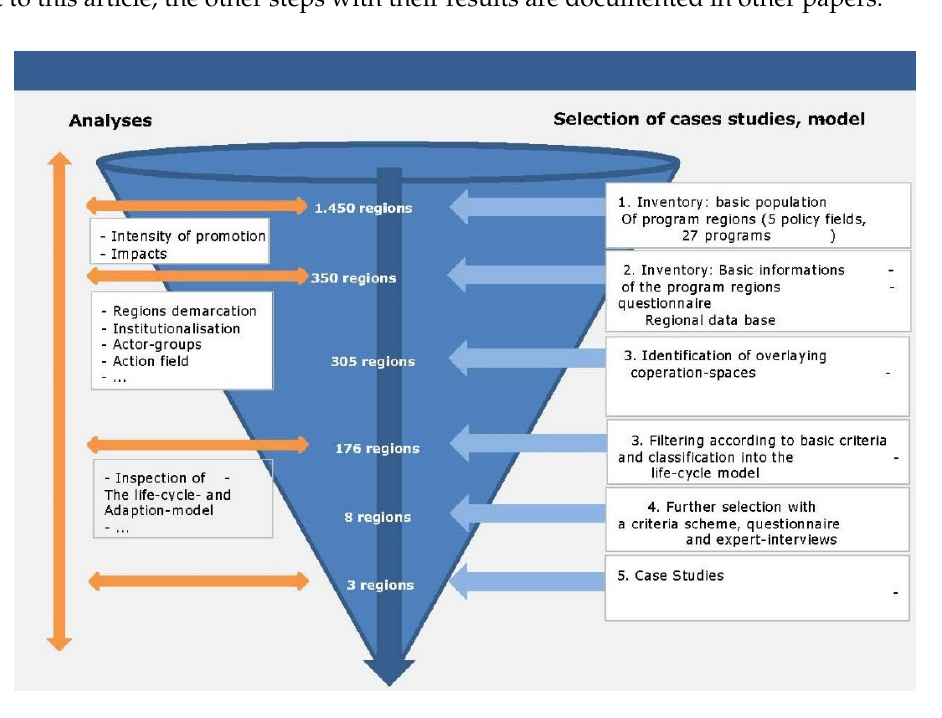
Figure 1. Steps of the empirical analysis.